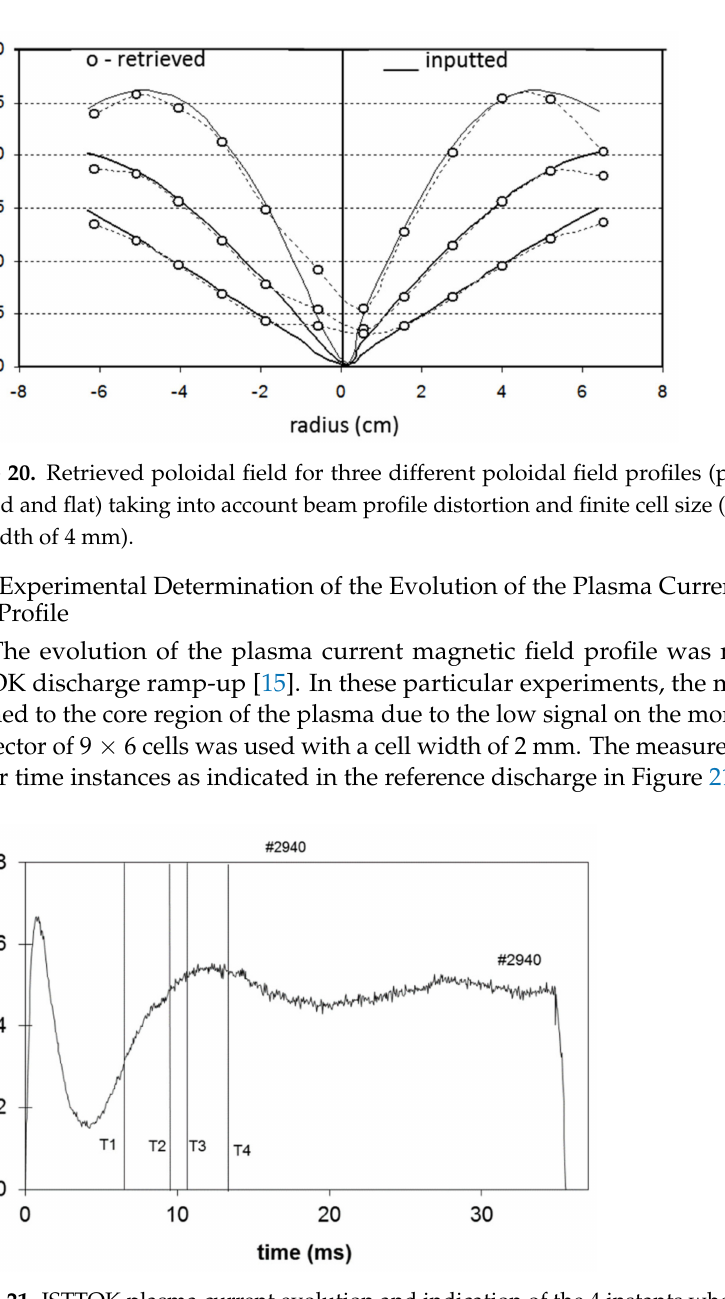
Figure 21. ISTTOK plasma current evolution and indication of the 4 instants when the poloidal field profile was determined (partially reprinted from